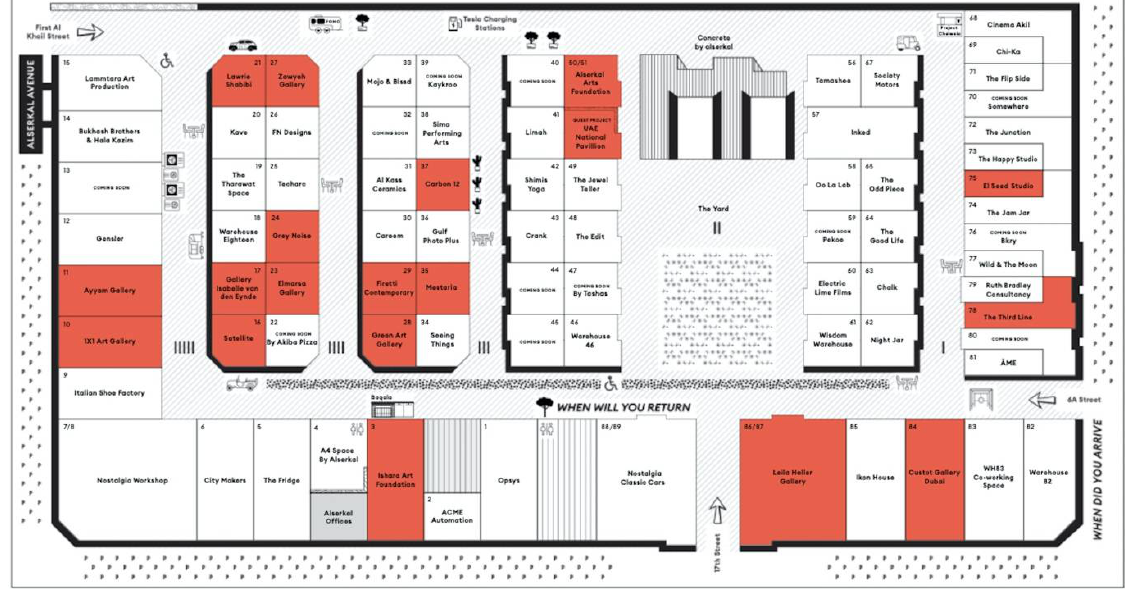
Figure 5. Map of Alserkal Avenue, 2021. Art spaces are highlighted in orange. Courtesy of Alserkal Avenue.